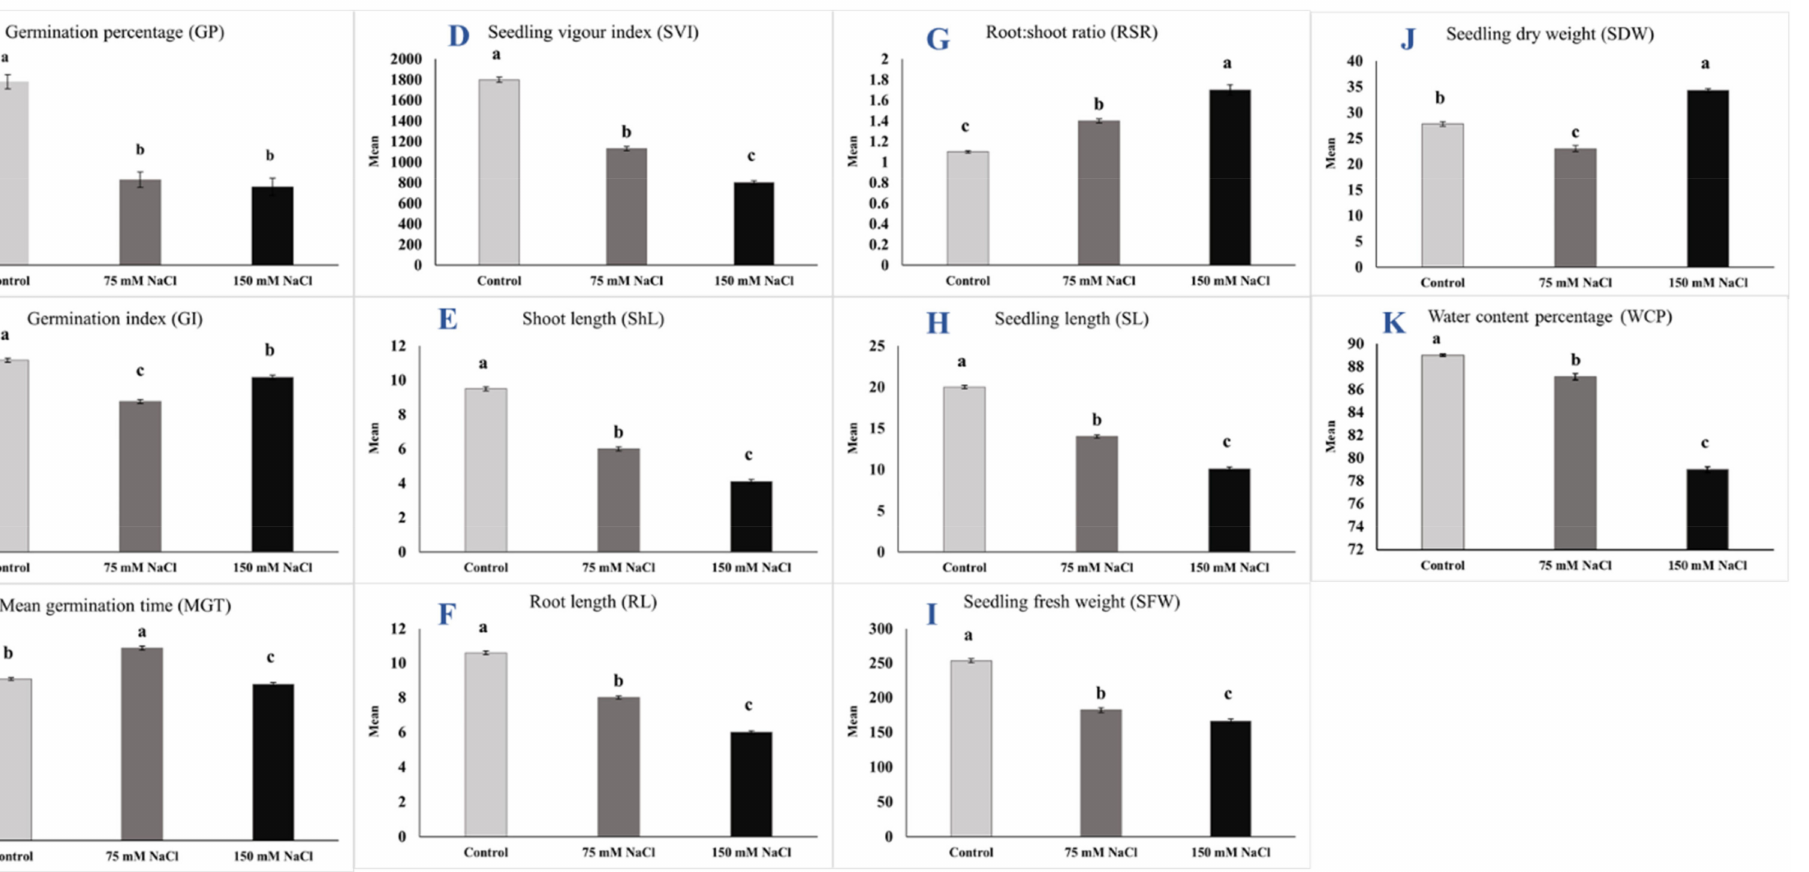
Figure 1. Means with standard errors of all studied traits under control, 75 mM NaCl, and 150 mM NaCl conditions (different letters mean significant differences). Note: ( A ) GP is germination percentage (%), ( B ) GI is germination index, ( C ) MGT is mean germination time (day), ( D ) SVI is seedling vigor index, ( E ) ShL is shoot length (cm), ( F ) RL is root length (cm), ( G ) RSR is root:shoot ratio, ( H ) SL is seedling length (cm), ( I ) SFW is seedling fresh weight (mg), ( J ) SDW is seedling dry weight (mg), and ( K ) WCP is water content percentage